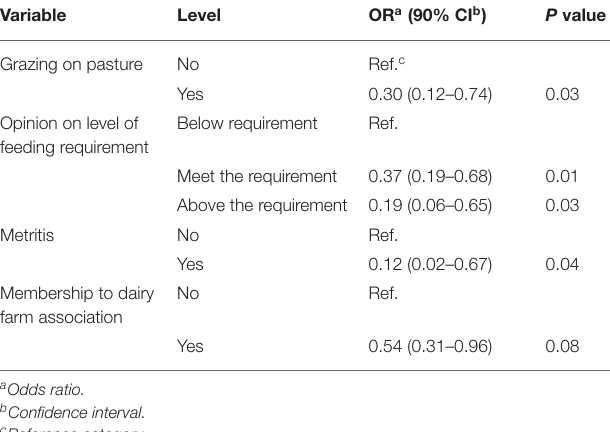
TABLE 4 | Final multivariate mixed logistic regression models describing the association ( P < 0.05) between risk factors and subclinical hypocalcemia based on data on 221 cows of 81 dairy farms in North-West Ethiopia and modeling a random herd effect.